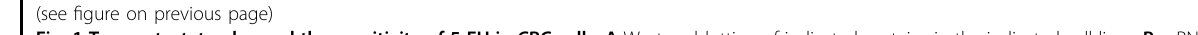
Fig. 1 Tazemetostat enhanced the sensitivity of 5-FU in CRC cells. A Western blotting of indicated proteins in the indicated cell lines. B mRNA level of indicated genes were analyzed by real-time PCR in the indicated cell lines. C Indicated cells were treated increasing dose of 5-FU for 24 h. Cell viability was analyzed by MTS. D Indicated cells were treated increasing dose of tazemetostat for 24 h. Cell viability was analyzed by MTS. E FHC cells were treated with 2.5 μ g/mL 5-FU, 0.5 μ M tazemetostat, or their combination for 24 h. Cell viability was analyzed by trypan blue. F CCD-18Co cells were treated with 2.5 μ g/mL 5-FU, 0.5 μ M tazemetostat, or their combination for 24 h. Cell viability was analyzed by trypan blue. G HCT116 cells were treated with 2.5 μ g/mL 5-FU, 0.5 μ M tazemetostat, or their combination for 24 h. Cell viability was analyzed by trypan blue. H DLD1 cells were